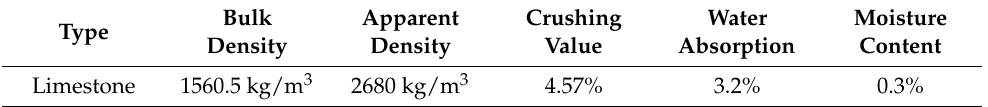
Table 3. Properties of coarse aggregate.